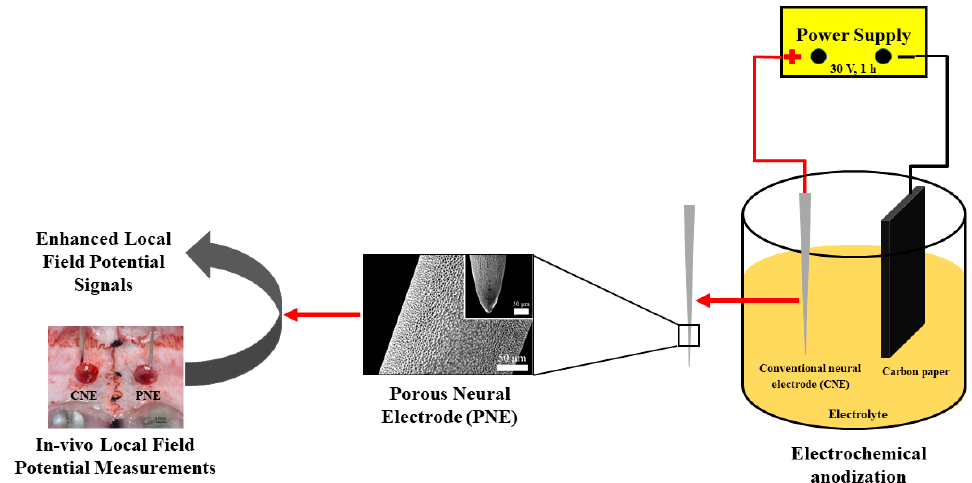
Figure 1. Schematic flow diagram depicting the synthesis and application of PNE for enhanced LFP signal detection (PNE, porous neural electrode; LFP, local field potential).